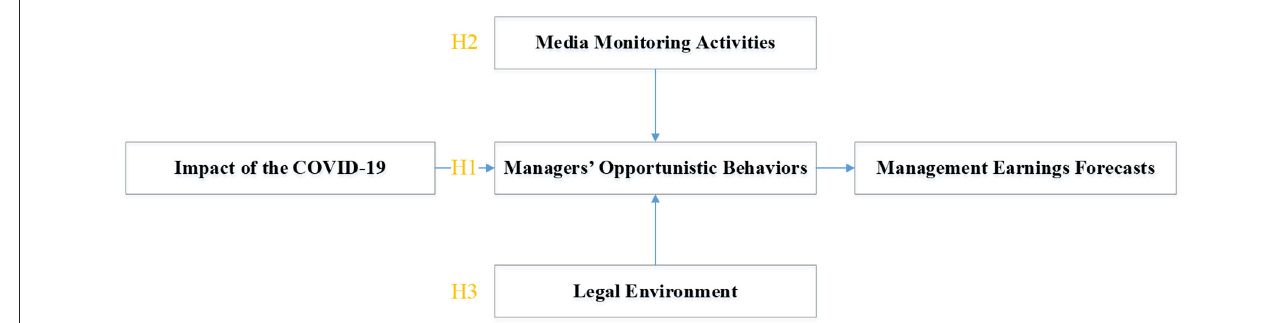
FIGURE 1 | Theoretical